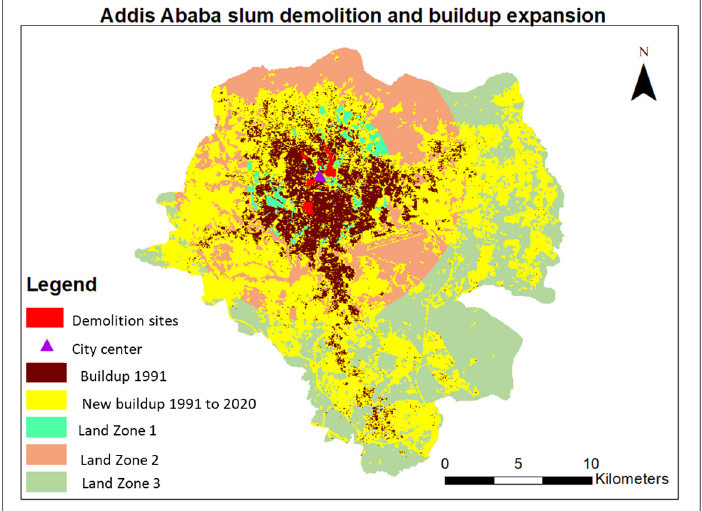
Figure 19. Addis Ababa’s central core urban renewal (demolition) and urban expansion towards the periphery between 1991 and 2020.